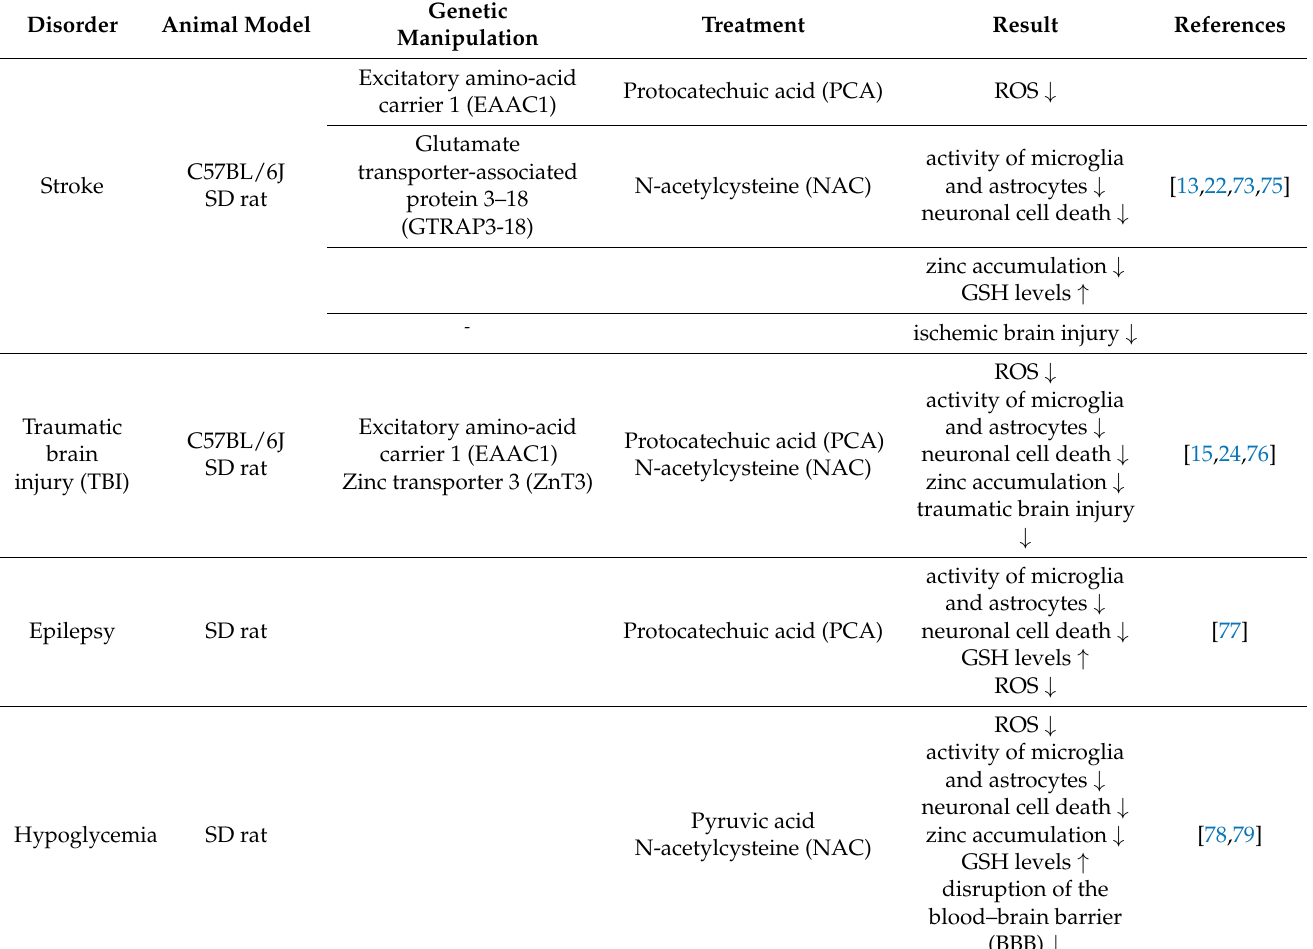
Table 1. Neuroprotective effects of GSH supplementation in several brain